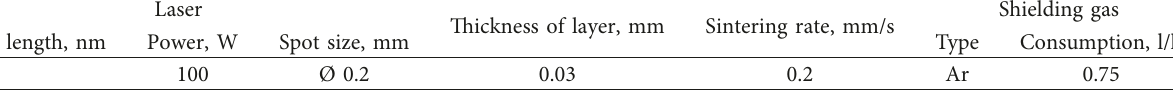
Table 1: Characteristics of SLS laser and sintering parameters.